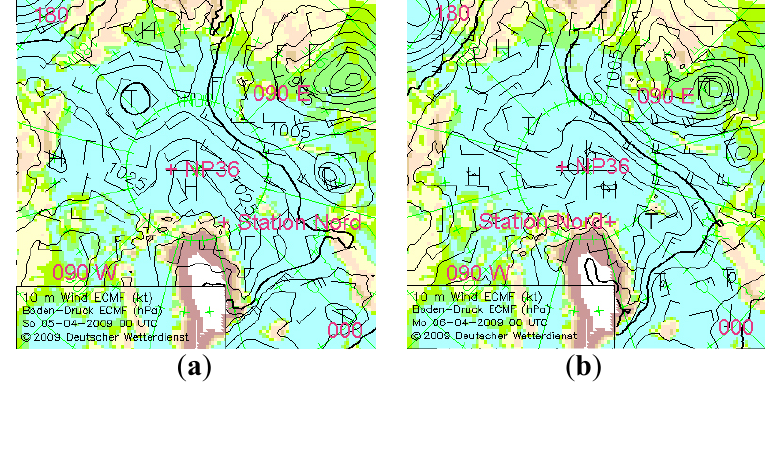
Figure 2. ECMWF analyses of ( a ) sea level pressure 5 April 2009 at 00 UTC, ( b ) sea level pressure 6 April 2009 at 00 UTC ( c ) relative humidity at 700 hPa 7 April 2009 at 00 UTC, ( d ) sea level pressure 8 April 2009 at 00 UTC, ( e ) sea level pressure 10 April 2009 at 12 UTC, ( f ) sea level pressure 11 April 2009 at 00 UTC. In panel c, the areas of relative humidity exceeding 90% are marked by thick lines. Here, snowfall is possible. “T” shows low-pressure areas, “H” high-pressure